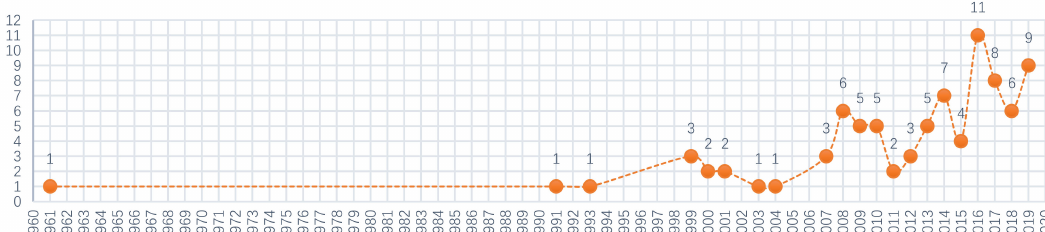
Figure 3. Statistics of the establishment time and number of art exhibitions